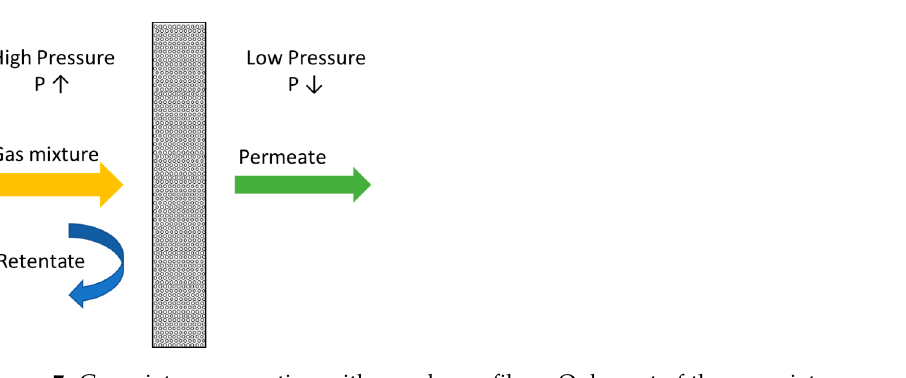
Figure 7. Gas mixture separation with membrane films. Only part of the gas mixture permeates through the membrane, passing from the high pressure to the low-pressure side.